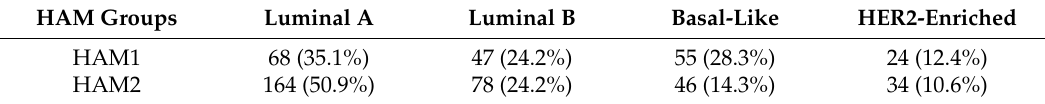
Table 1. Distribution of four molecular intrinsic subtypes in HAM1 and HAM2 groups.